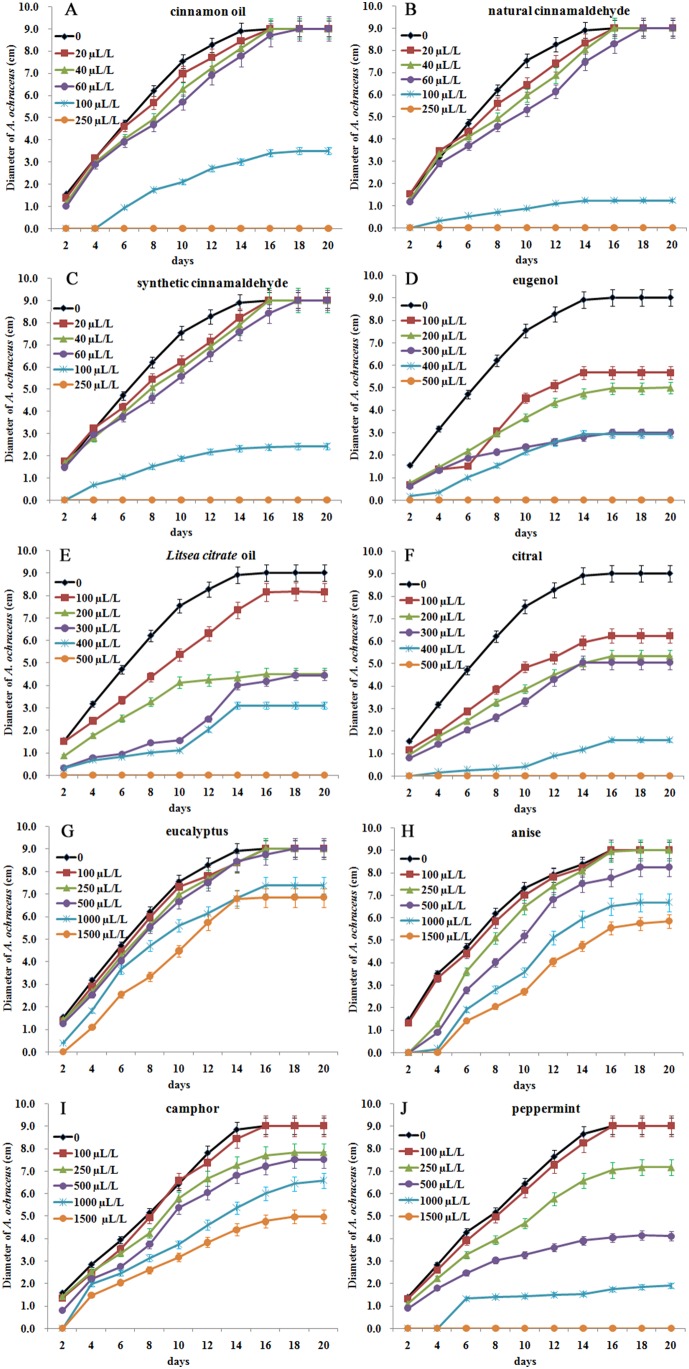
The effect of ten essential oils on the growth of A. ochraceus in contact assay.